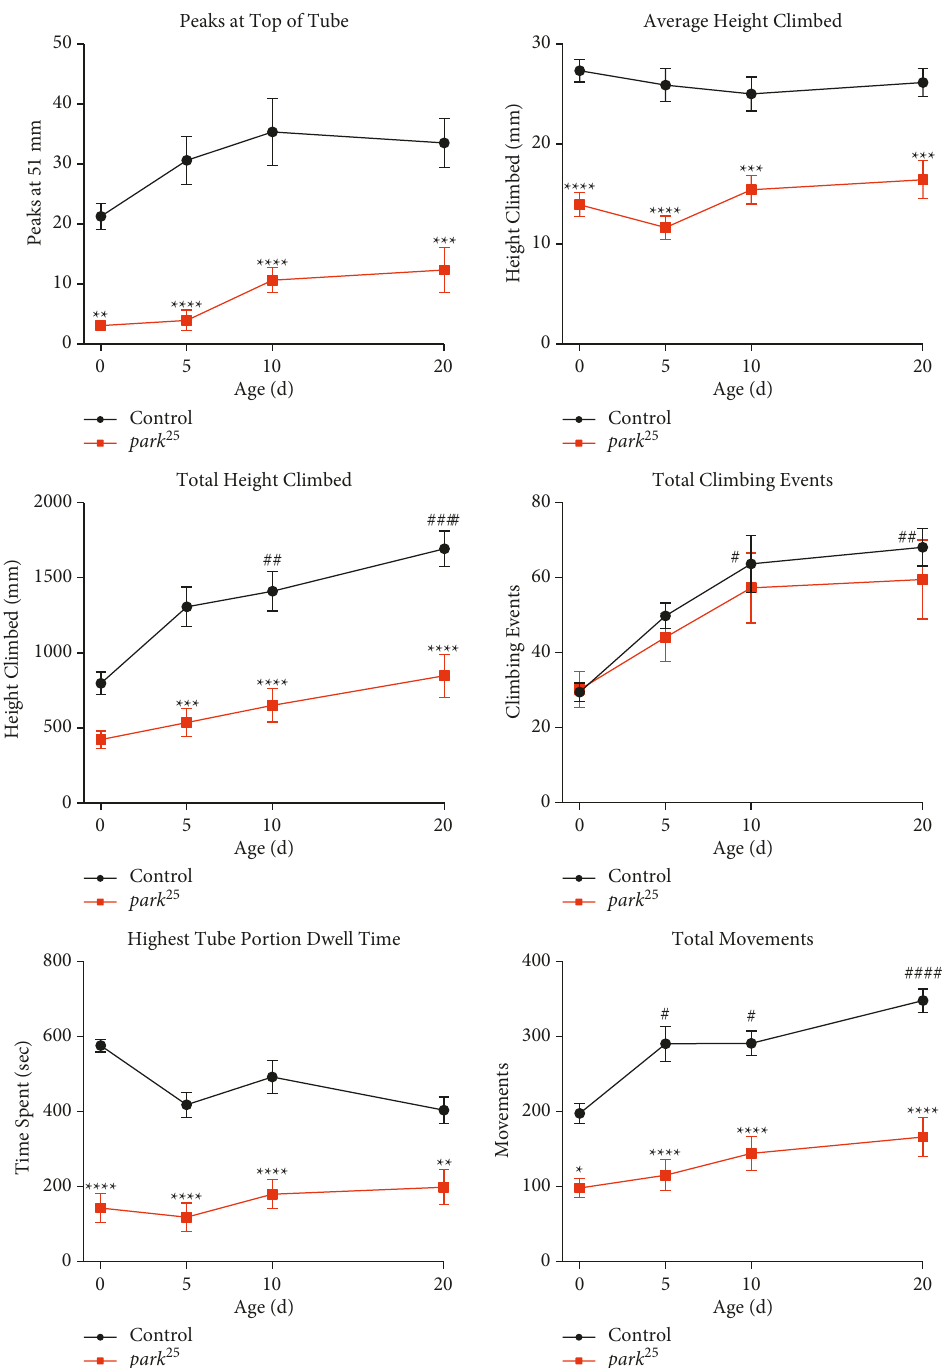
Figure 1: Time course of climbing deficits in homozygous park 25 flies. Control and homozygous park 25 mutants were collected and aged to 0, 5, 10, and 20 days and assayed in the MBM climbing assay. Different climbing metrics are shown, see Methods for definitions. Data are presented as mean and SEM. Results from a post hoc Tukey’s HSD analysis are shown: Asterisks represent comparisons between genotypes, ∗∗∗∗ � P < 0 . 0001, ∗∗∗ � P < 0 . 001, ∗∗ � P < 0 . 01 ∗ � P < 0 . 05, pound signs represent comparisons within genotypes, ### � P < 0 . 001, ## � P < 0 . 01 # � P < 0 . 05. The results of each data point are from three separate experiments with an n ≥ 21